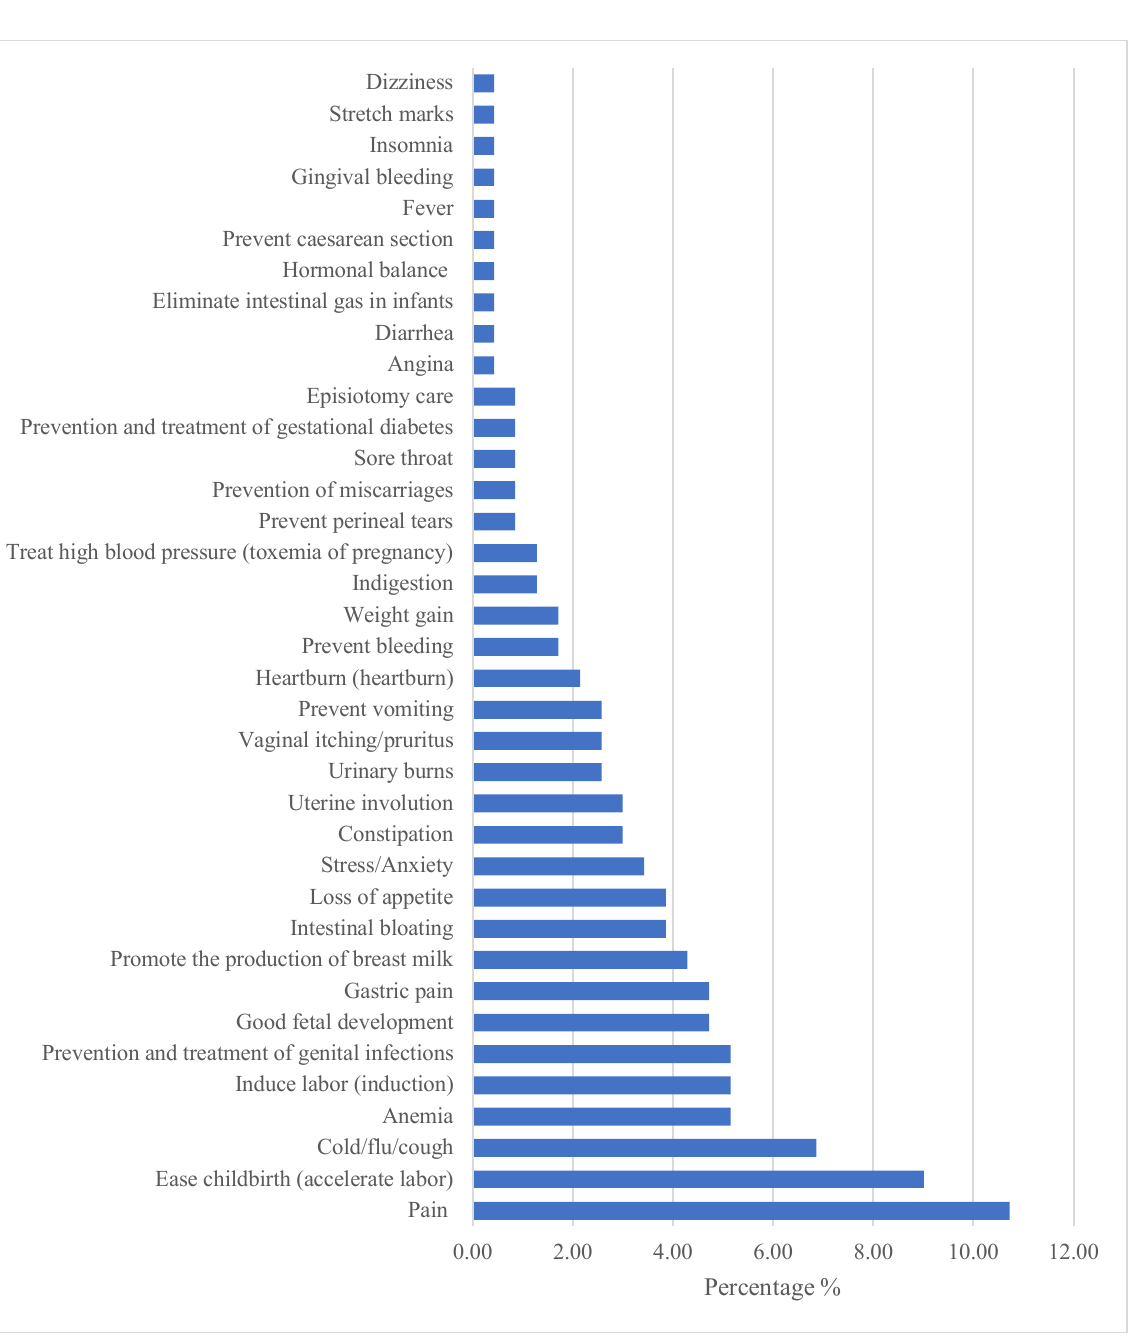
Figure 3. Reasons for the use of medicinal plants by women in Guelmim .